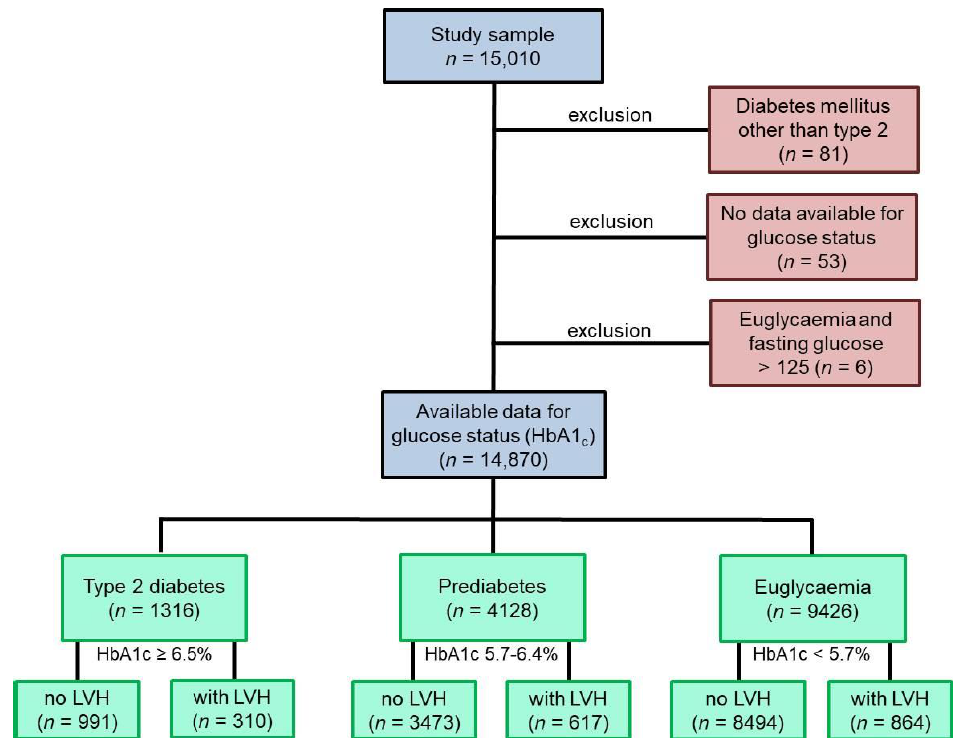
Figure 1. Study flow chart. Blue boxes represent the GHS study cohort, of which the individuals included into the present study were chosen. Red boxes show excluded individuals. Green boxes represent the subgroups of the final study sample. A total of 14,870 subjects were included. Individuals with a type of diabetes mellitus other than T2DM were excluded, also if data for glucose states were not available and in case of normal HbA1c but fasting Glucose >125 mg/dL. No LVH was present if LVMI ≤ 95 gm/m 2 (women) or ≤ 115 gm/m 2 (men) and RWT ≤ 0.42; all other states were defined as present LVH. GHS: Gutenberg Health Study. LVMI: left ventricular mass index. LVH: left ventricular hypertrophy. RWT: relative wall thickness. T2DM: type 2 diabetes mellitus.